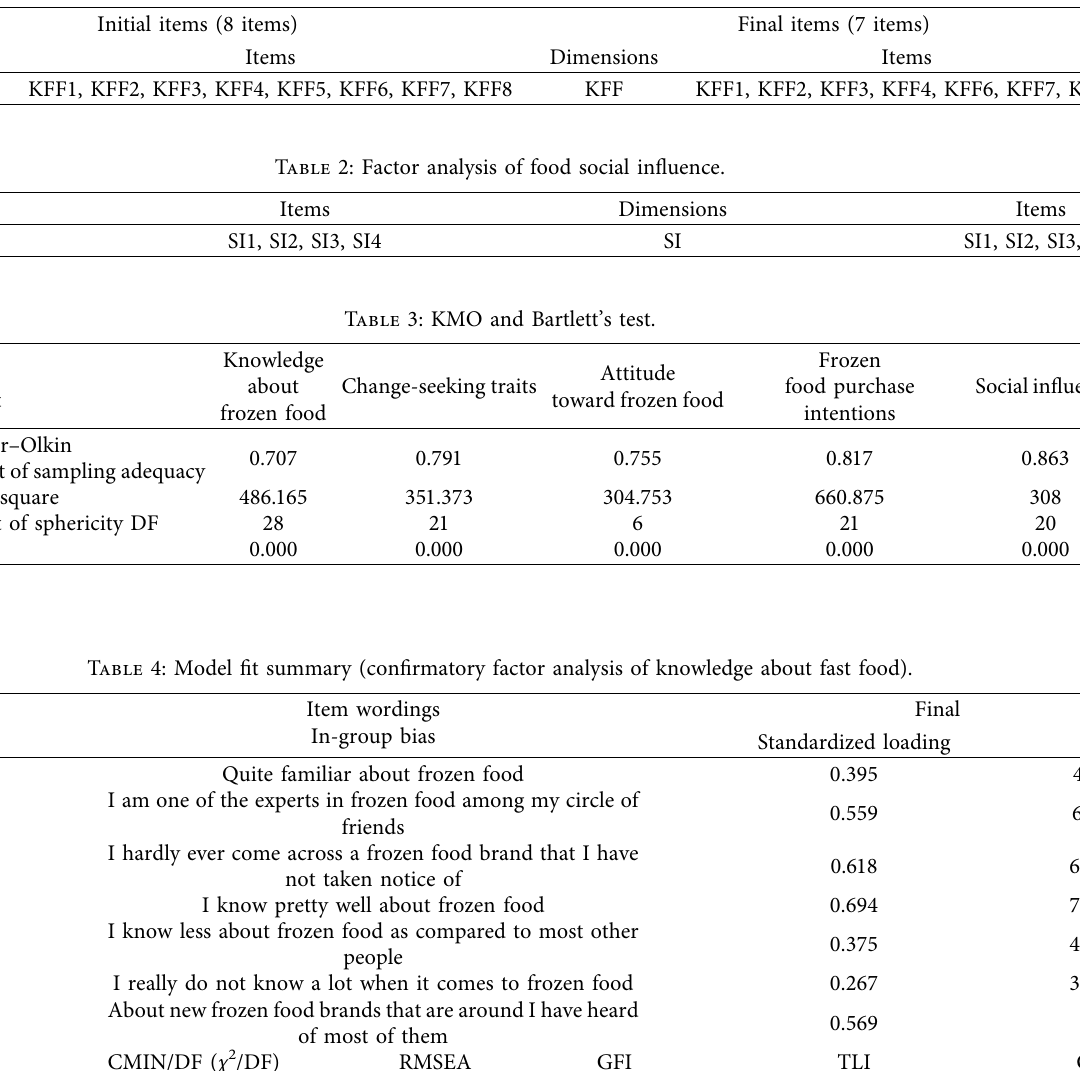
Table 1: Factor analysis of KFF (knowledge about fast food).